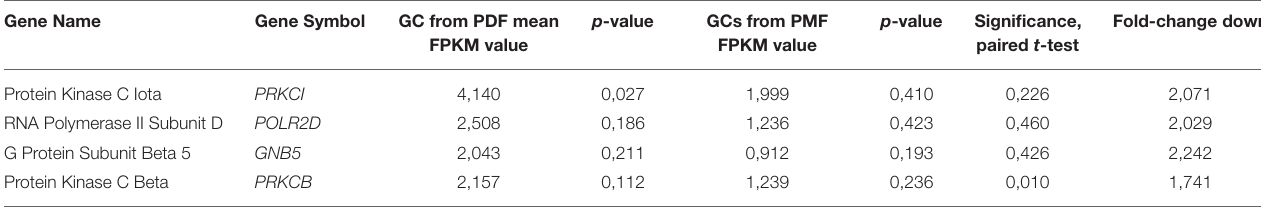
TABLE 3 | Differently expressed genes annotated “Androgen Signaling”